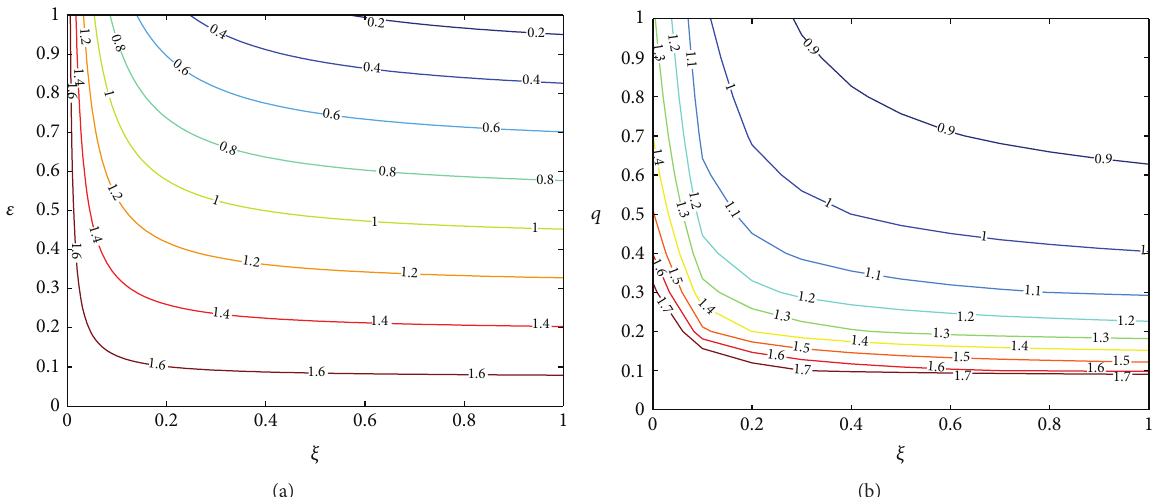
Figure 2: Contour plots of 𝑅 0 versus (a) vaccine efficacy 𝜖 and vaccination rate 𝜉 and (b) diagnosis rate 𝑞 and vaccination rate 𝜉 .